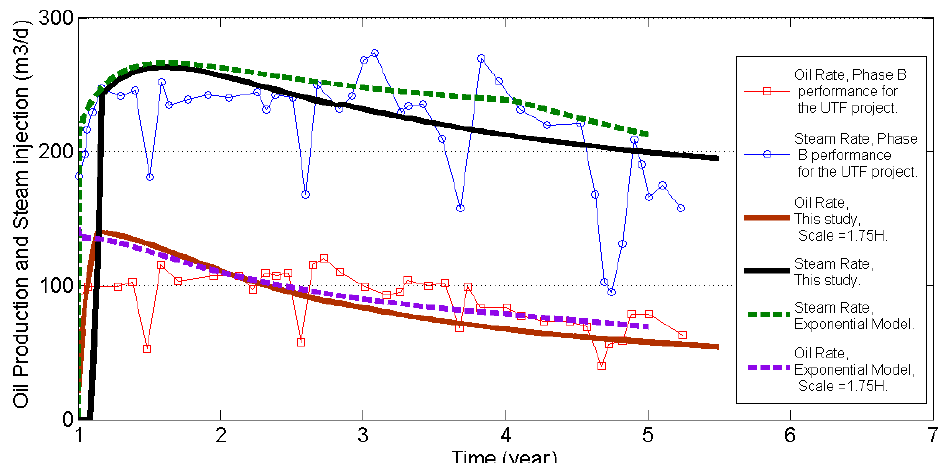
Figure 12. The oil production and steam injection rates from the proposed model, as well as field data, and phase B of the UTF project.